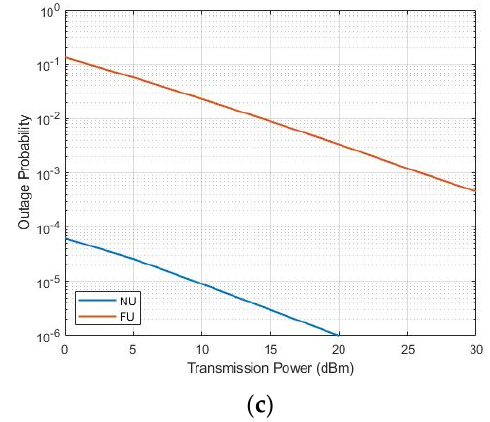
Figure 7. OP versus transmission power.